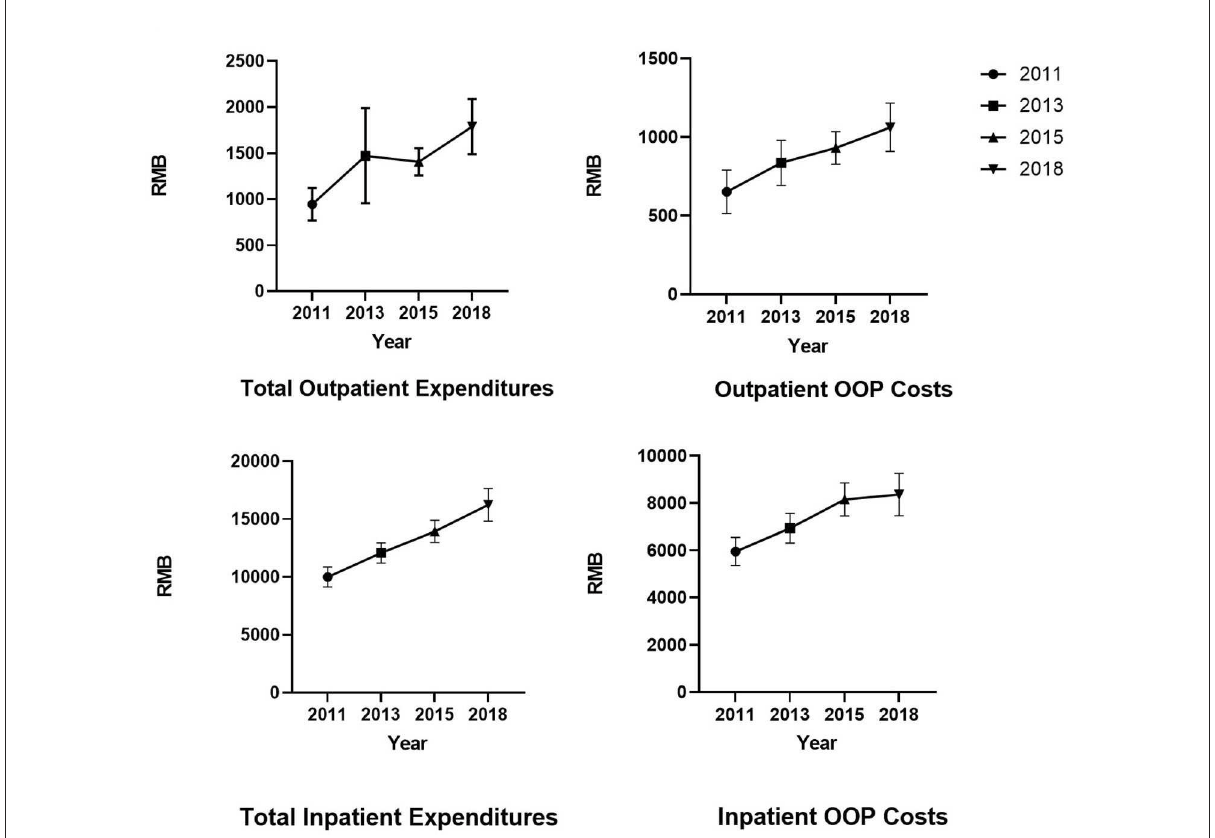
FIGURE1 The mean of total medical expenditures and out-of-pocket (OOP)